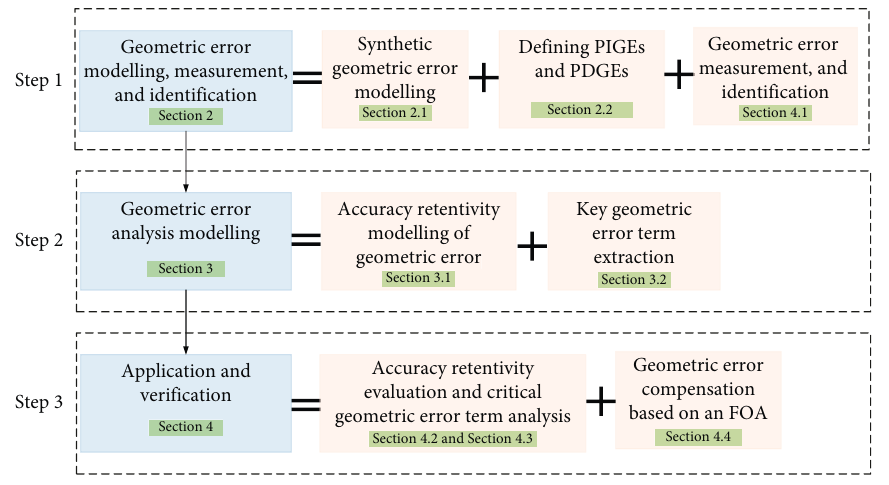
Figure 1: Framework of the proposed